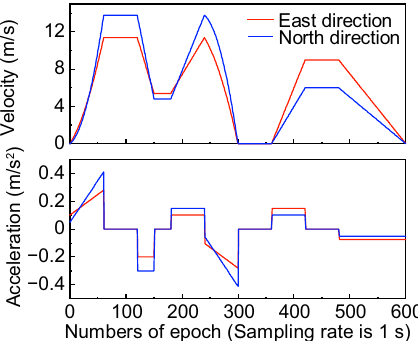
Fig. 1 Simulated horizontal velocity and acceleration of a vehicle in dynamic